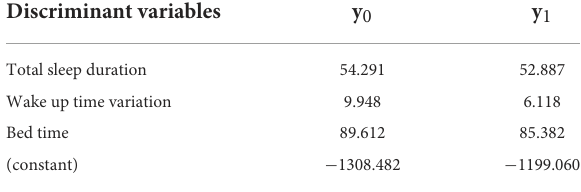
TABLE 9 Fisher function coefficients of 48–59 months age